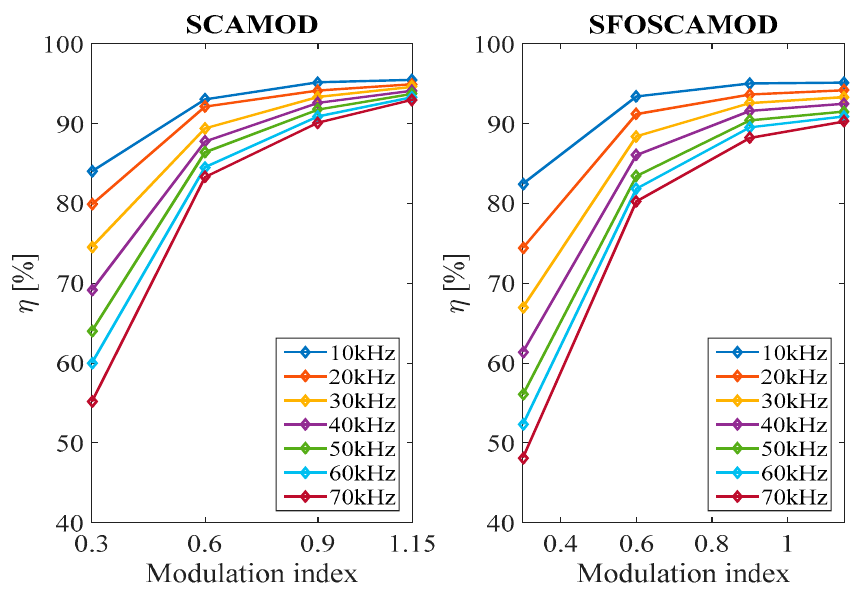
Figure 24. Experimental conversion efficiency trends of SCAMOD and SFOSCAMOD schemes. Additionally, the efficiency trends of the SCAMOD-based schemes are affected by the switching frequency effects. In detail, a reduction of the conversion efficiency has been observed as the switching frequency increases. Moreover, in the SCAMOD-based schemes, the SFO modulation signals do not generate any effects on the efficiency values. Figure 25 shows the comparison among modulation schemes with the same modulation signal as a function of the switching frequency and for different values of modulation index.